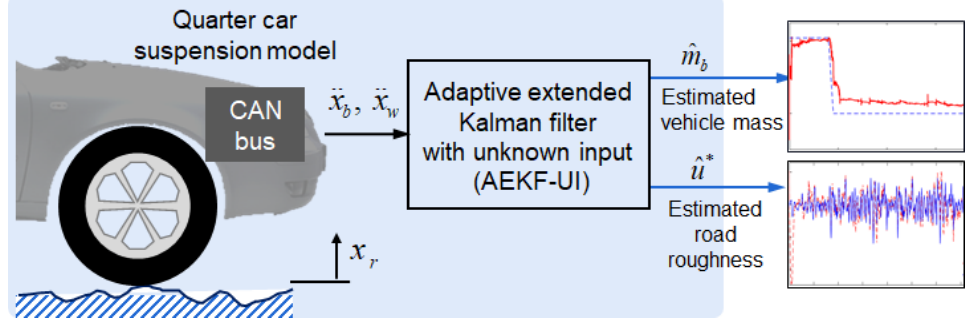
Figure 1. Simultaneous estimation of vehicle mass and unknown road roughness enabled by adaptive extended Kalman filtering of vehicle suspension systems.